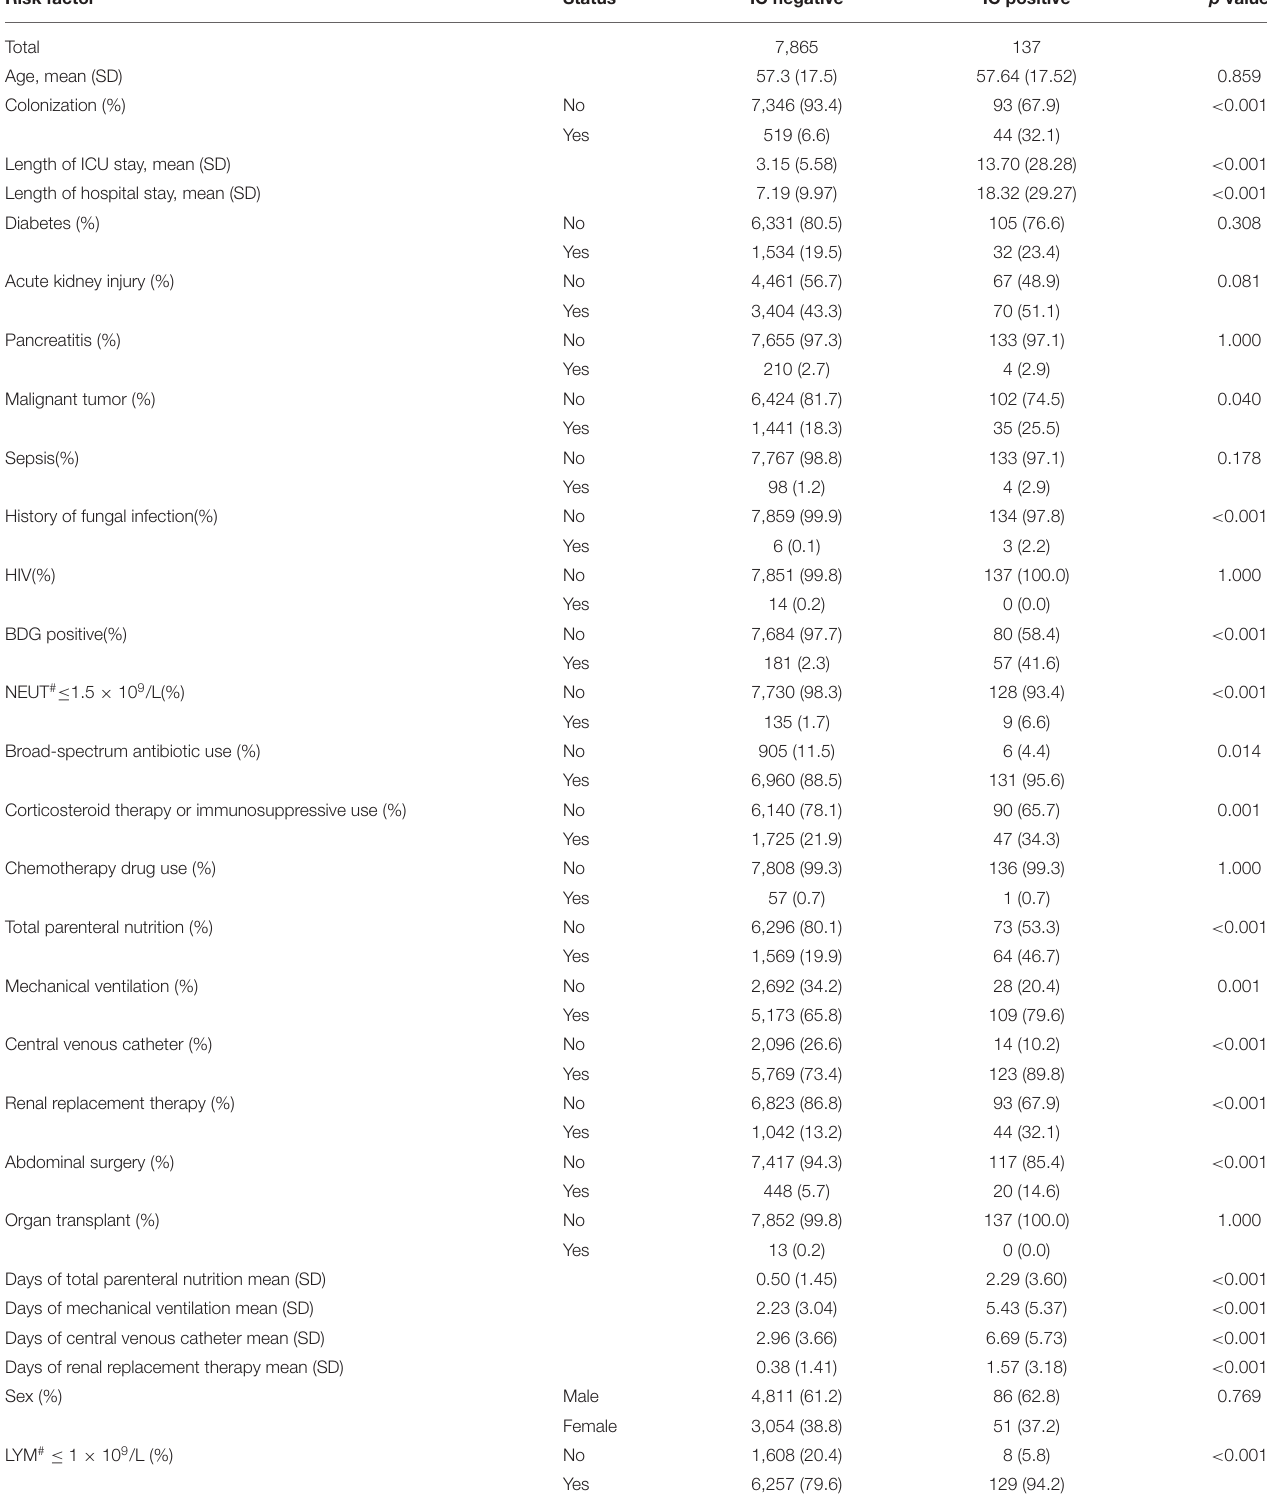
TABLE 2 | Distribution of 28 risk